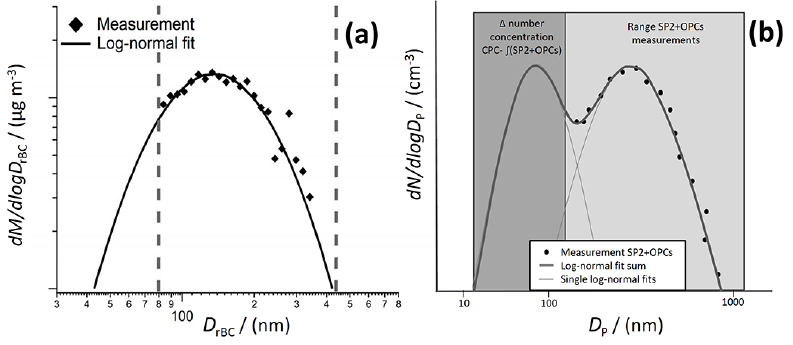
Figure 1. (a) Scheme illustrating the determination of rBC mass size distributions from SP2 measurements (diamonds) within the SP2 measurement range (between the grey dashed lines) and a log-normal fit (black line). Based on the fit, the total rBC mass concentration can be derived. For details see Sect. 2.2. dM/dlogD rBC : rBC mass size distribution. d N /dlog D p : particle number size distribution. (b) Scheme of the total particle size distributions measured: Dots represent the combined measurements of SP2 and FSSP-300 (accumulation mode; light grey box). The integral number concentration of particles smaller 0.14µm (Aitken mode; grey box) is derived from the difference of the CPC number concentration to integral number concentration of SP2 and FSSP 300 in the accumulation mode. Log-normal fits are applied to the measured size distribution and extrapolated toward smaller sizes. For details see Sect.